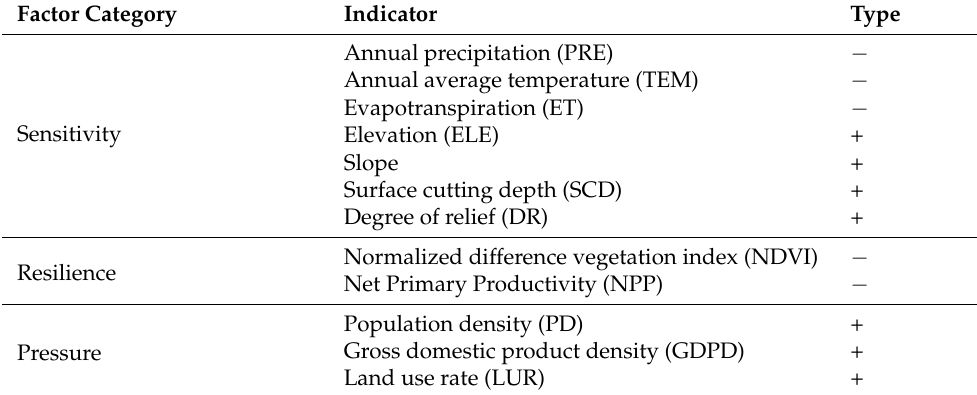
Table 4. Ecosystem vulnerability assessment indicators for the Qinghai-Tibet